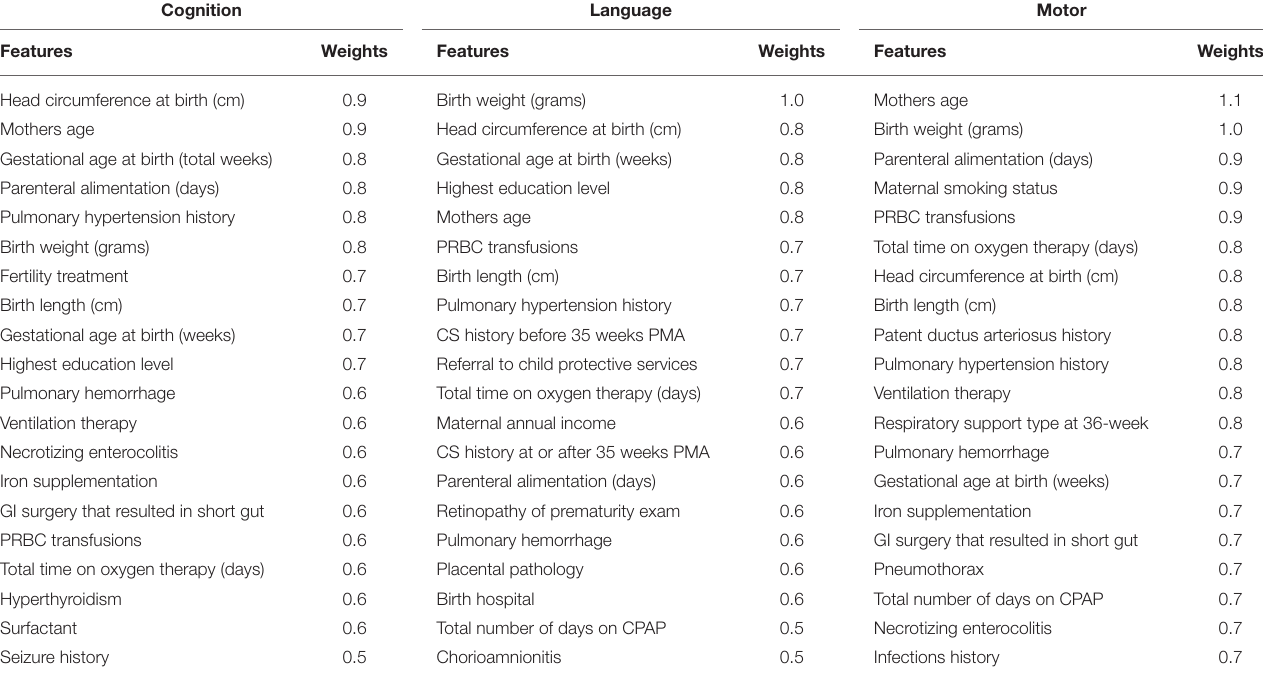
TABLE 7 | Top discriminative clinical features for early prediction of cognitive, language, and motor deficits. Cognition Language